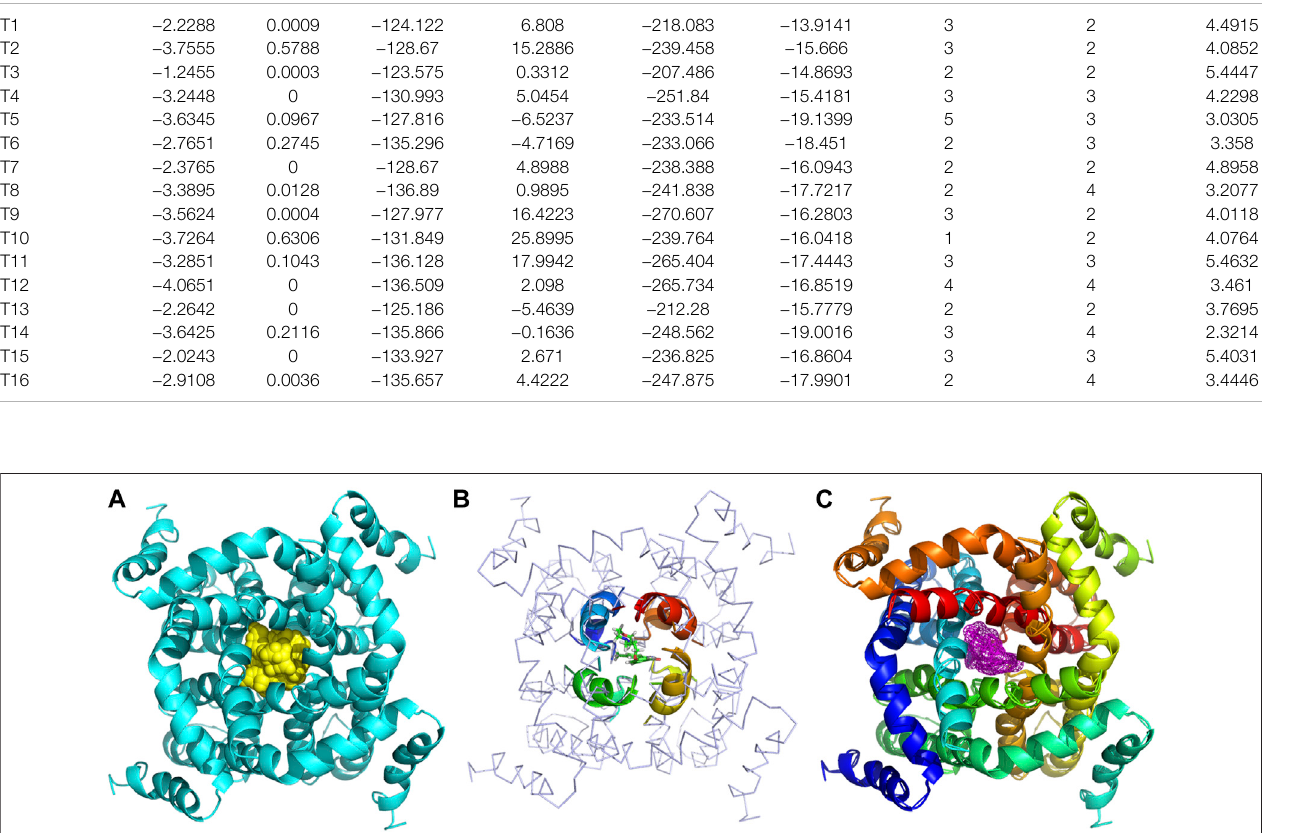
TABLE 3 | Docking scores of the target compounds with Kv1.5 via Sybyl sur fl ex software. Compounds